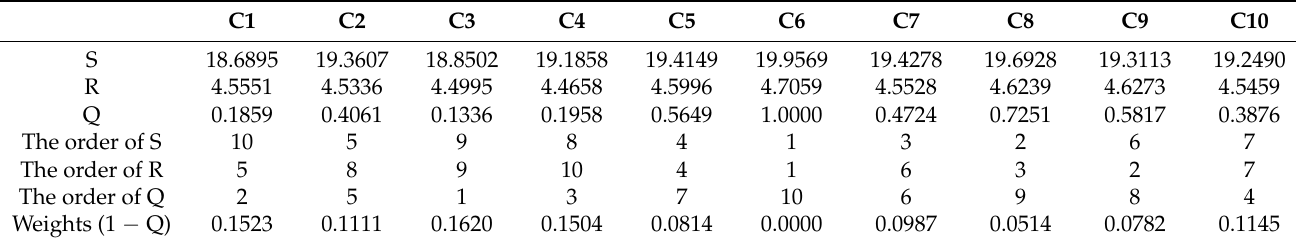
Table 20. Ranking results of big data